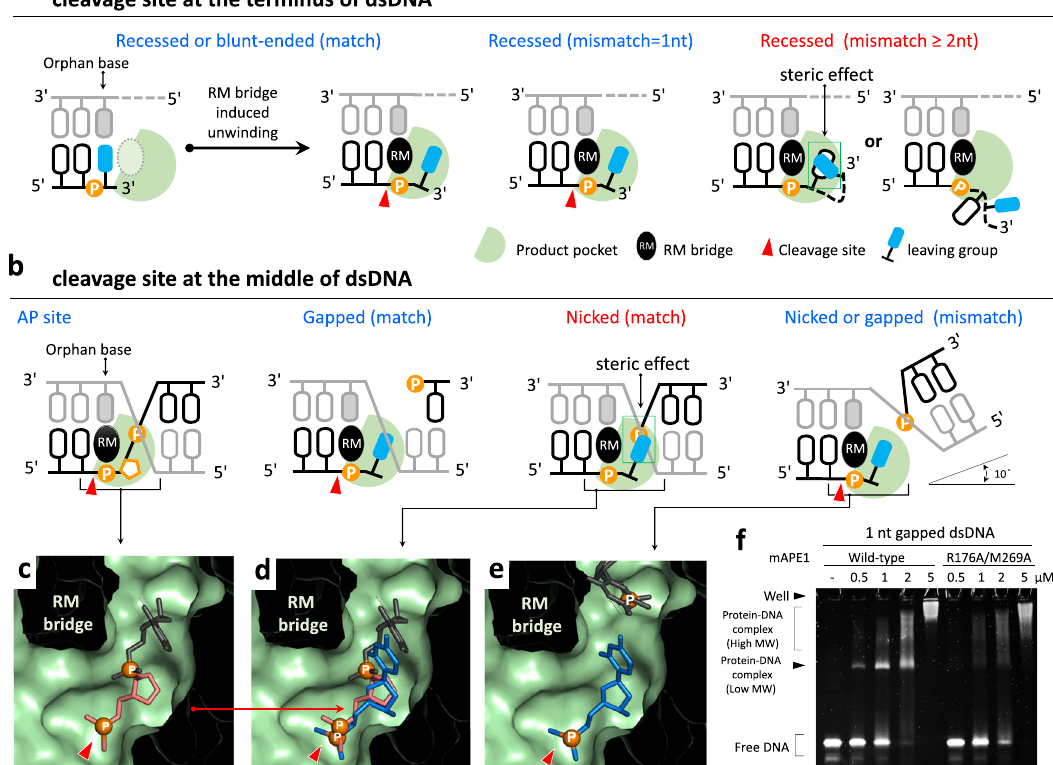
Fig. 7 The induced space- fi lling model for APE1 in processing various duplex DNAs. Based on the positions of cleavage sites in dsDNA substrates, they are classi fi ed into two groups, a terminal binding and b middle binding. c The close-up view of the product pocket and AP site-containing dsDNA (PDB entry: 5DFI). Only the AP site (orange), upstream and downstream phosphoryl group, and a downstream nucleotide (black) of the substrate dsDNA is shown. e The close-up view of the product pocket and the 1-nt mismatched nicked dsDNA (PDB entry: 5WN5). Only the leaving group (blue) and a downstream nucleotide (black) of the substrate dsDNA is shown. d Superposition of the leaving group in 1-nt mismatched nicked dsDNA (blue) and the AP site (orange), upstream and downstream phosphoryl group, and a downstream nucleotide (black) in the AP site-containing dsDNA. The base region of the leaving group is overlapped to the downstream phosphoryl group near the AP site. f EMSA measurements of wild-type and double mutant (R176A/ M269A) mAPE1 binding with matched 1-nt gapped dsDNA. The band of protein – DNA complex with a lower molecular weight is not observed in the binding of mAPE1 double mutant. f Source data are provided as a Source Data fi